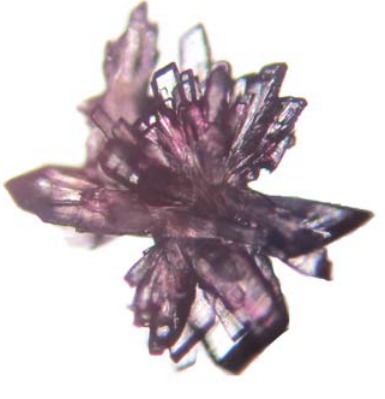
Figure 2. View of crystal under a microscope at